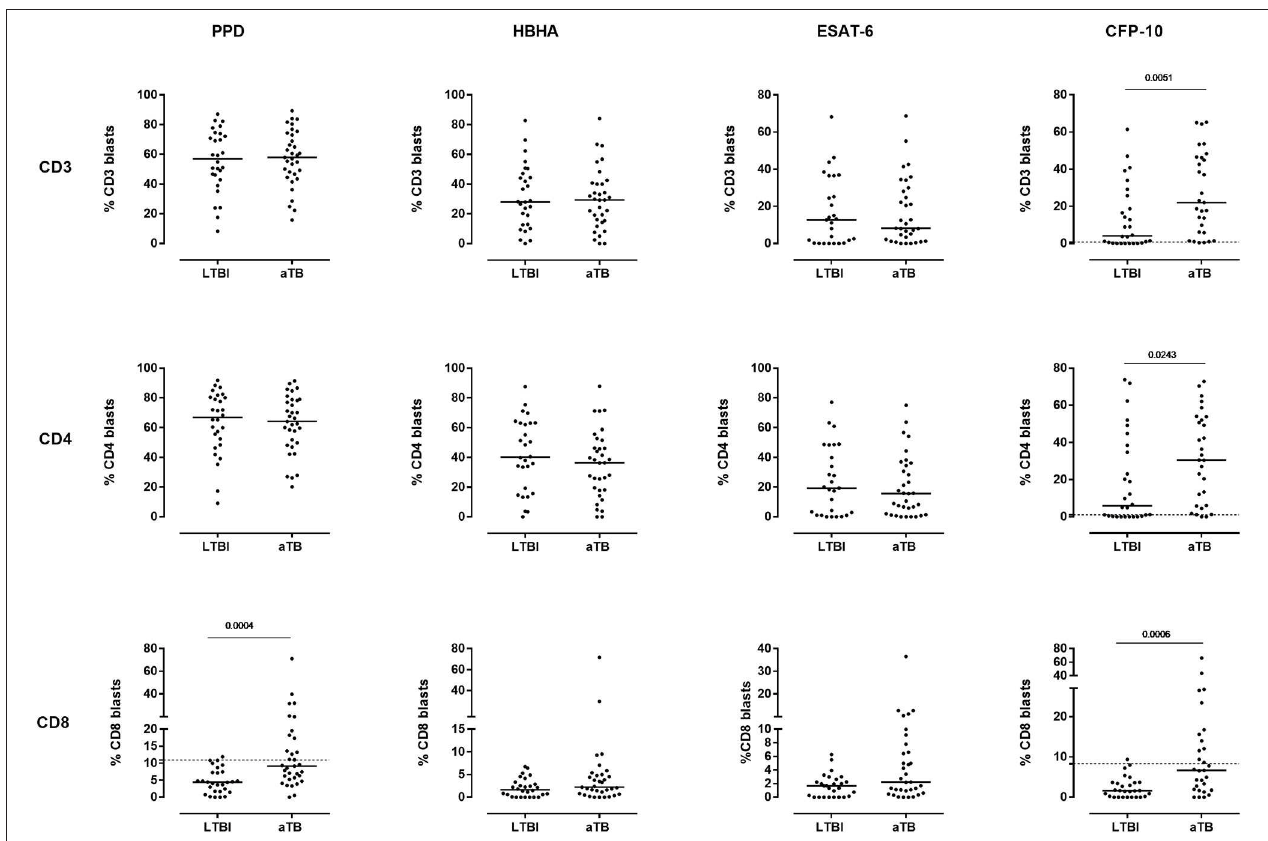
FIGURE 4 | Comparison of the percentages of T cell blasts induced by mycobacterial antigens between children with LTBI and those with aTB. Ten-fold diluted whole blood was incubated during 7 days at 37 ◦ C with PPD (4 µ g/ml), HBHA (10 µ g/ml), ESAT-6 (10 µ g/ml) or CFP-10 (5 µ g/ml), as indicated, and the cells were labeled with anti-CD3, anti-CD4, and anti-CD8 monoclonal antibodies. The percentages of CD3 + (upper panels), CD4 + (middle panels) and CD8 + (lower panels) blasts were determined by flow cytometry. Each symbol represents the value from an individual child after deduction of the percentage obtained in the non-stimulated condition. The horizontal filled lines indicate the medians. For the tests providing statistically significant differences between the two groups of infected children, horizontal dotted lines were added to indicate the cut-off of positivity. Statistical analysis was performed by Mann-Whitney U test. LTBI, latently TB infected; aTB, active